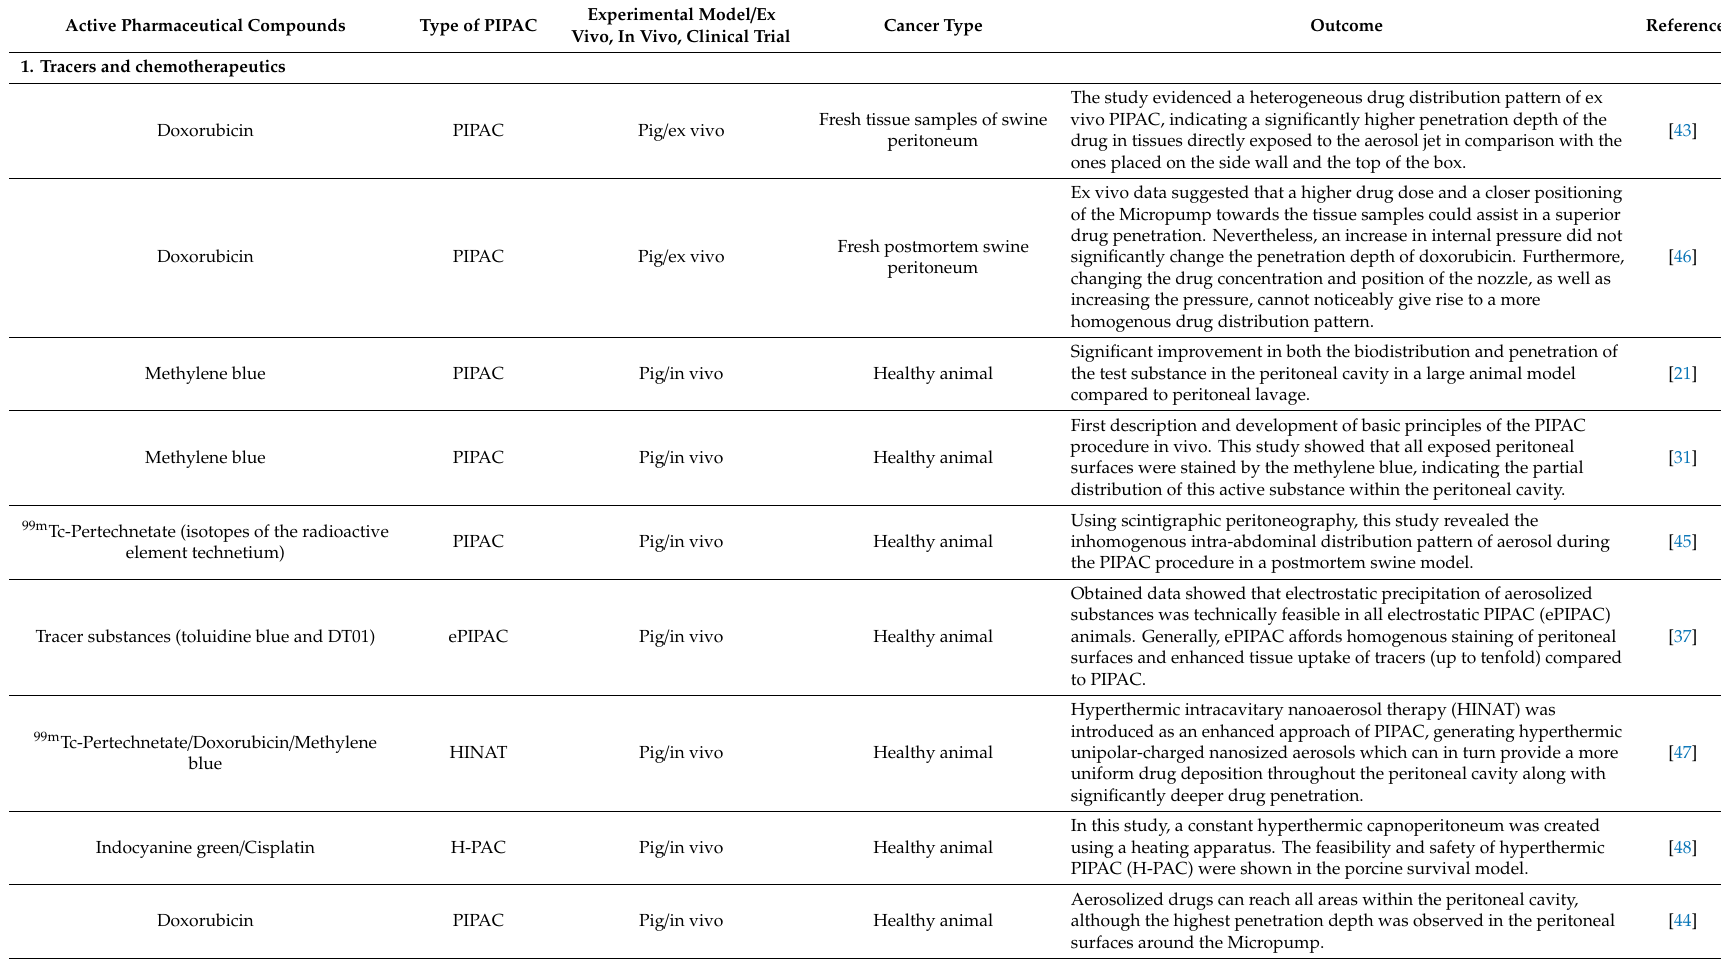
Table 1. Examples of preclinical and clinical studies on the e ffi cacy of Pressurized Intraperitoneal Aerosol Chemotherapy